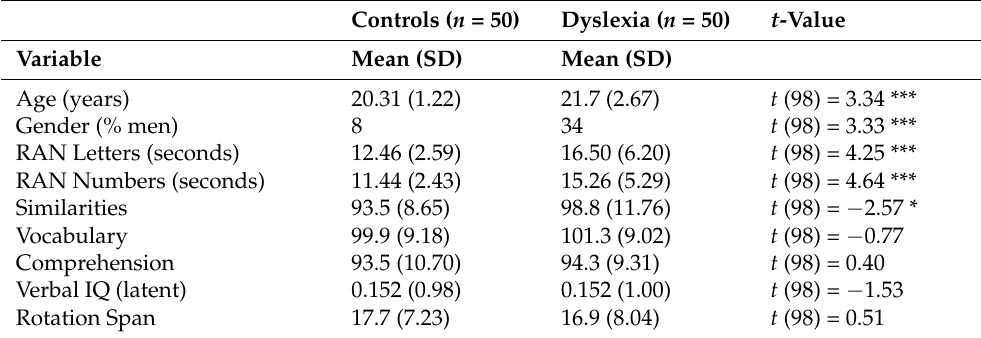
Table 2. Means and standard deviations for demographic variables, Rapid Automatised Naming, verbal intelligence, and working memory for the two diagnostic